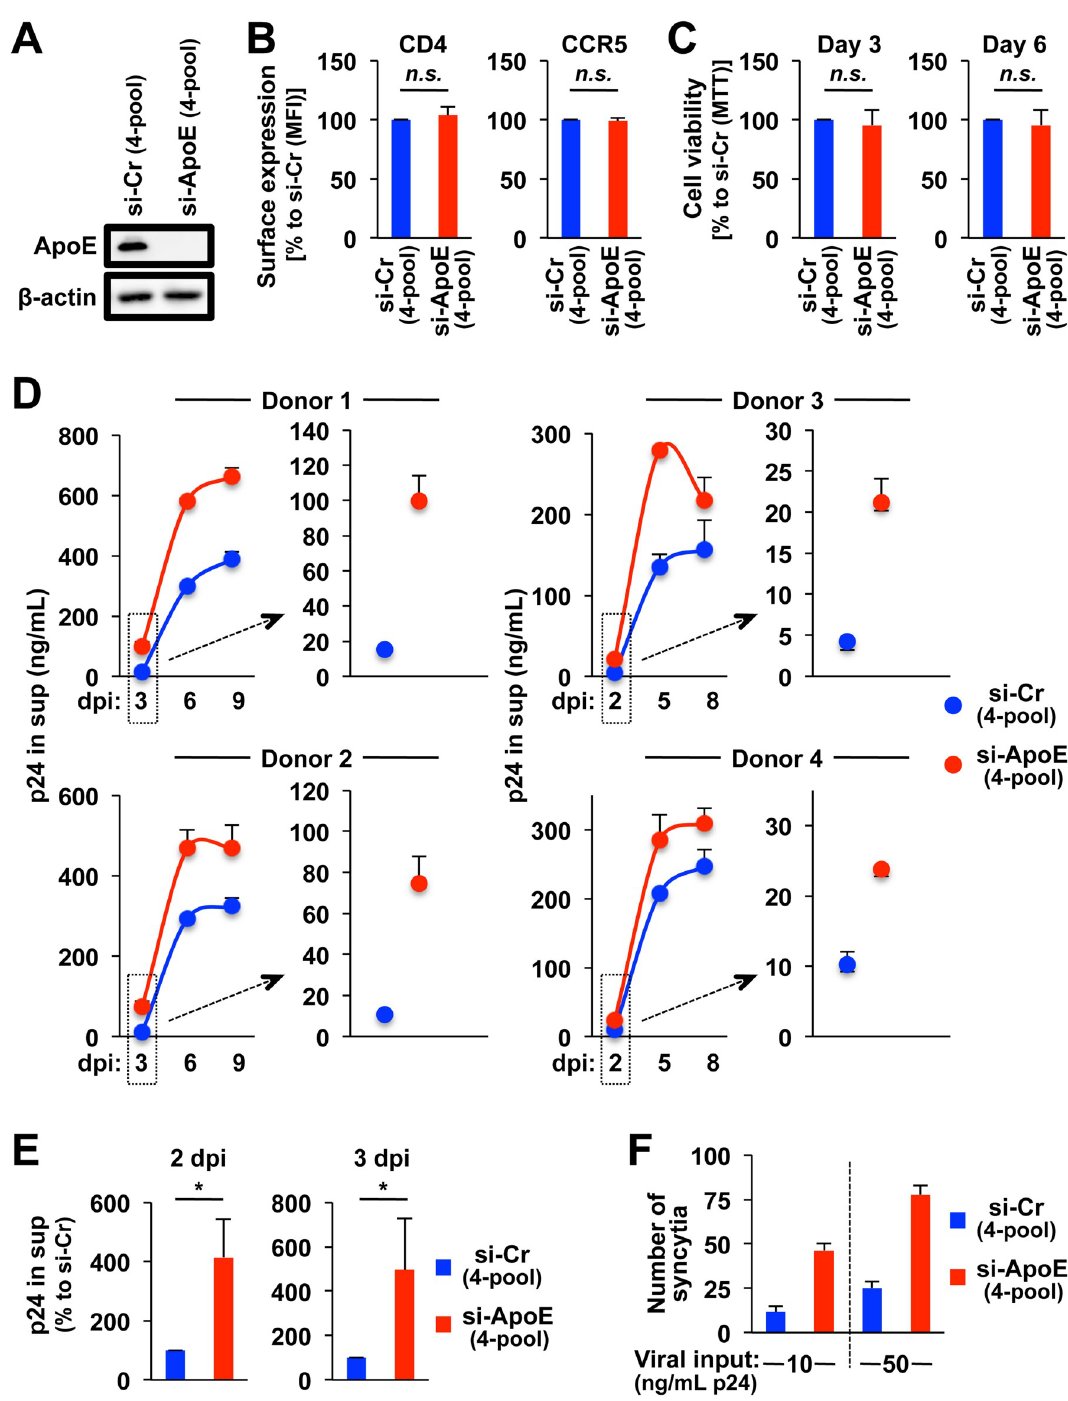
Fig 2. Effect of ApoE knockdown on HIV-1 production in MDMs. (A) MDMs were transfected with either ApoE-targeting siRNA (“si-ApoE”) or non-targeting siRNA as a control (“si-Cr”), which is a mixture (SMARTpool) of 4 siRNAs (“4-pool”), cultured for 2 days, and analyzed for their ApoE levels by western blot. Anti- β -actin blot was used as a loading control. Data shown are representative of experiments obtained from 4 different donors with similar results. (B) MDMs were transfected as in (A), cultured for 2 days, and analyzed for their cell surface CD4 (left panel) and CCR5 (right panel) expression by flow cytometry. The mean fluorescence intensity (MFI) values of ApoE siRNA-transfected cells are represented as percentages relative to those of control siRNA-transfected cells. Results for MDMs obtained from 3 different donors are summarized. n . s ., not significant. (C) MDMs were transfected as in (A), cultured for 3 (left panel) or 6 days (right panel), and analyzed for their viability by the MTT assay. The